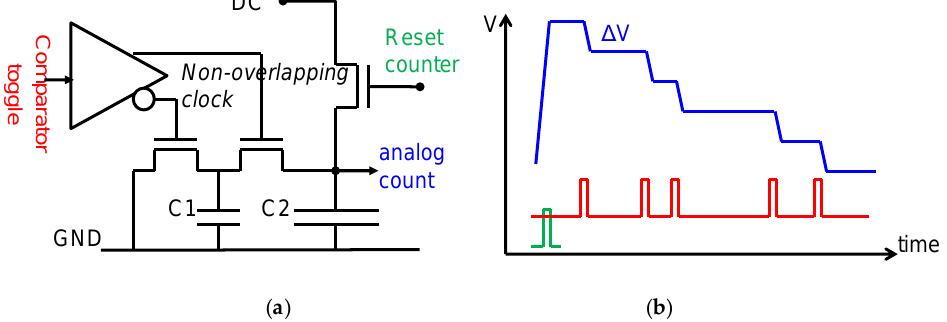
Figure 6. Analog domain counter. ( a ): circuit concept. ( b ): signals as expected on key nodes of the circuit concept.